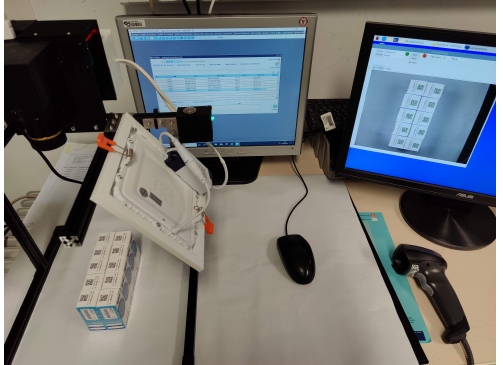
Figure 9. Prototype installed and tested at hospital pharmaceutical facilities. The right monitor presents the developed application. At left the hospital computer receiving the Data Matrix codes to